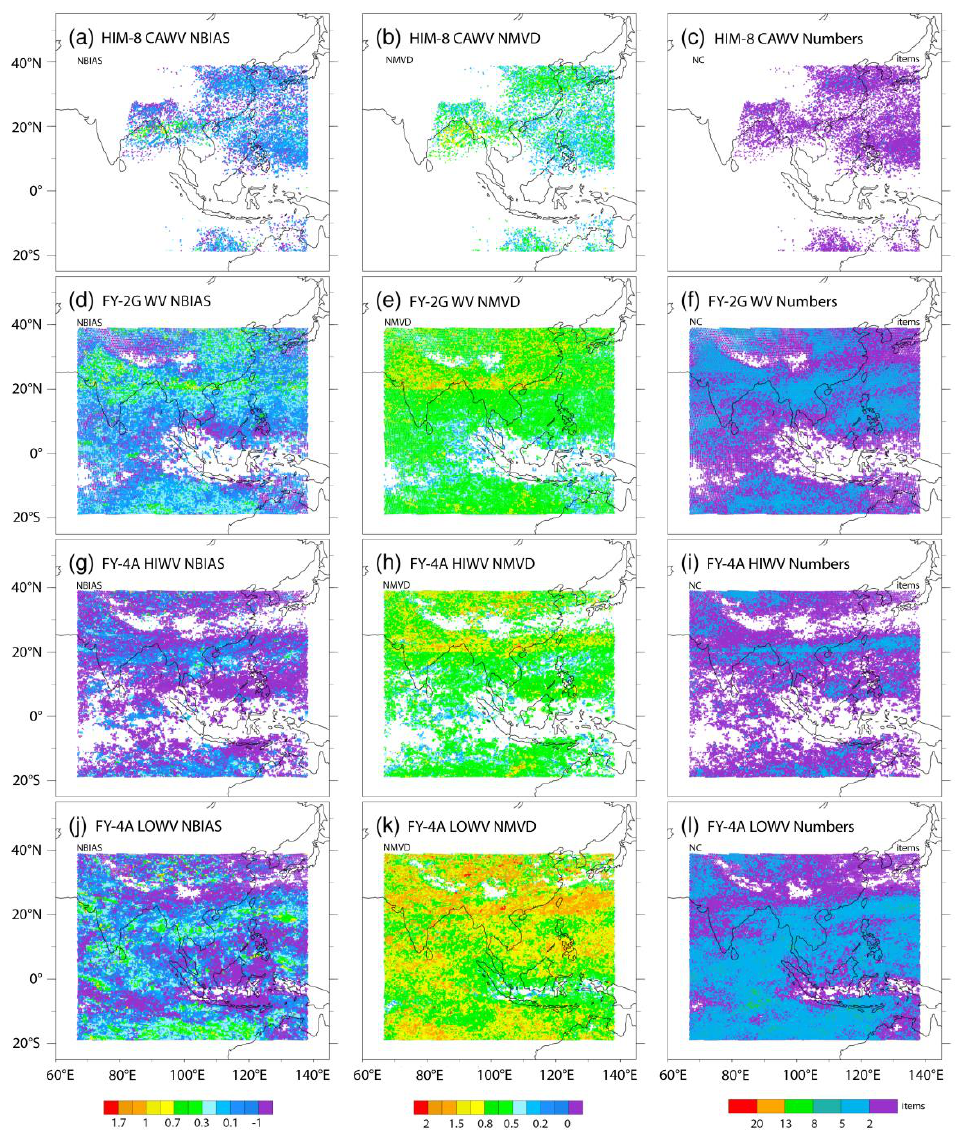
Figure 13. Same as Figure 12, but for mid-level WV AMVs averaged. Note that the CTWA from HIMA-8 AMVs was not available at the mid-level. HIMA-8 AMVs was not available at the